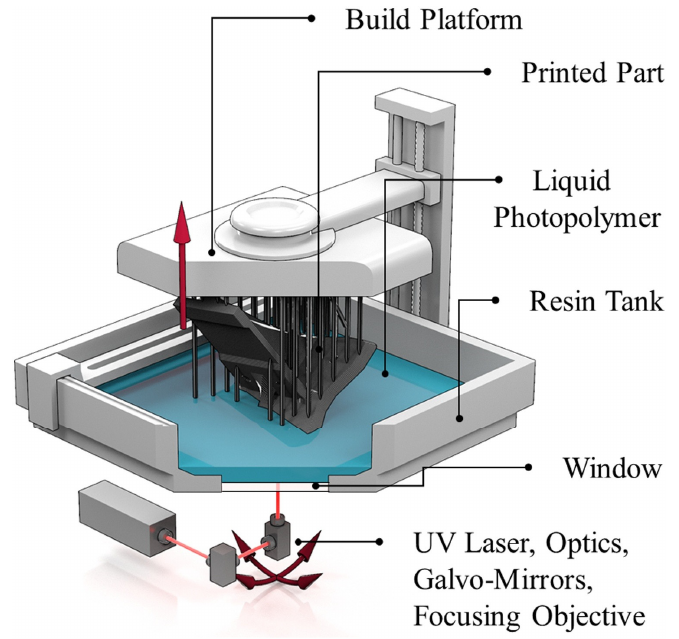
Figure 2. Schematic of 3D printing with SLA (reproduced with permission from Reference [21], Copyright 2020 Elsevier).